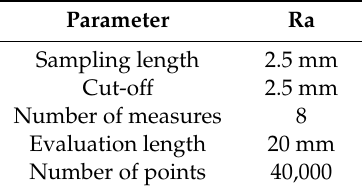
Table 2. Profilometer settings.